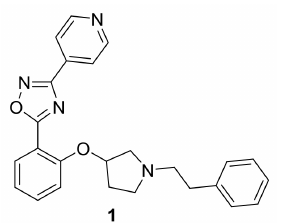
Figure 1. Structure of hit compound 1